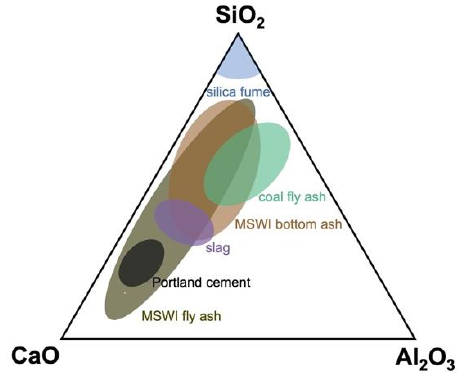
Figure 1. Schematic diagrams of concrete at different scales (derived from [61,64–66]). C-S-H is mes- oporous with high surface areas. Hydrated Ca of C-S-H can be substituted by HMs, and the layered nanostructure adsorbs many organics and ions.